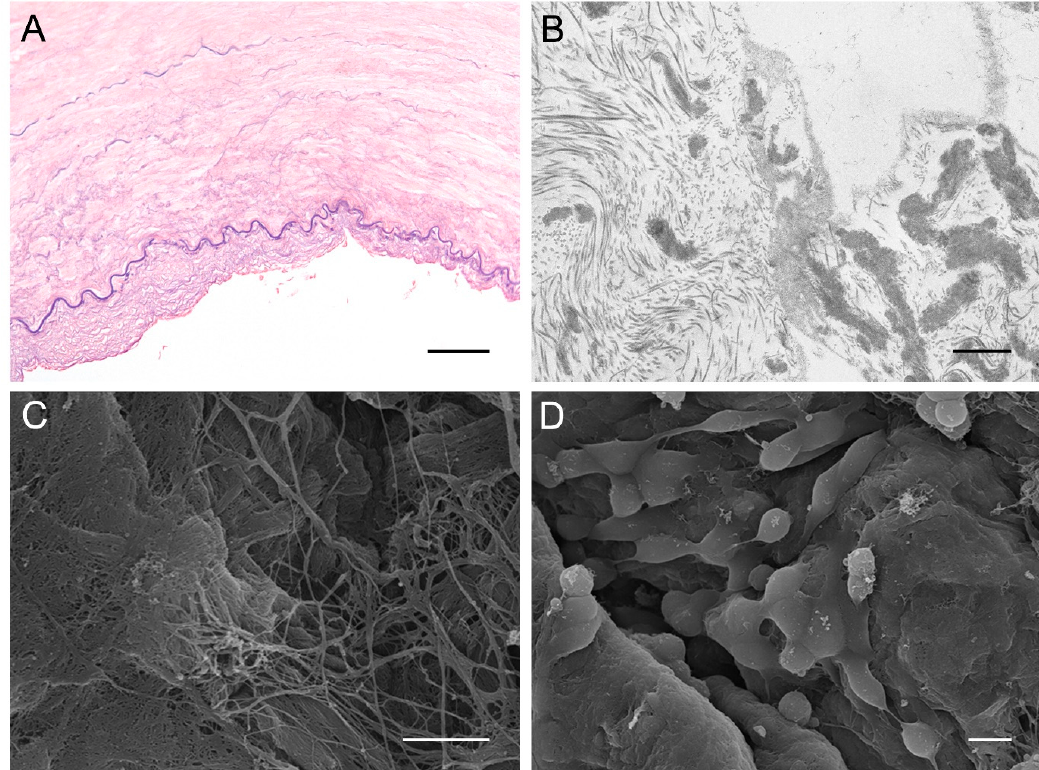
Figure 3. Scaffolds from human radial artery and umbilical cord Wharton’s jelly. Hematoxylin/eosin staining ( A ) and transmission electron microscope micrograph ( B ) of decellularized radial artery. Ultrastructural appearance at electron scanning microscope of Wharton’s jelly scaffold before ( C ) and 24 h after SHSY-5Y cells seeding ( D ) (unpublished data). Wharton’s jelly was decellularized,